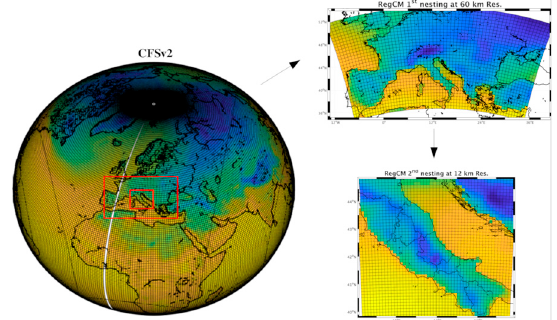
Figure 1. Domains for the modeling chain adopted in this study. Global-scale CFS providing initial and boundary conditions for the RegCM-d1 over Europe (60 km resolution) which in turn defines initial and boundary conditions for the second RegCM-d2 downscaling over Central Italy at 12 km resolution.